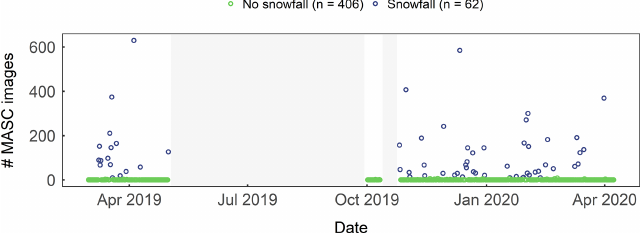
Figure A3. The number of images with objects larger than 0.54mm 2 captured by the operational MASC instrument during coinciding radiosonde profiles from 28 February 2019 to 7 April 2020. Radiosondes were launched twice a day, at 11:30 and 23:30UTC. Images considered were captured within a time span of 15min before each radiosonde launch. Cases (i.e. 15min time intervals) with 10 or more of such images are classified as snowfall events ( n = 62, blue dots). The others are classified as no-snowfall events ( n = 406, green dots). No data (grey area) were collected in the summer months (May to September) and during a technical interruption between 11 and 25 October 2019.